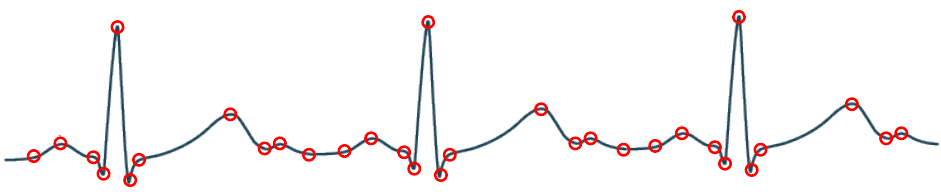
Figure 1. Concept of proposed feature point extraction based on turning angle detection for an ECG signal.